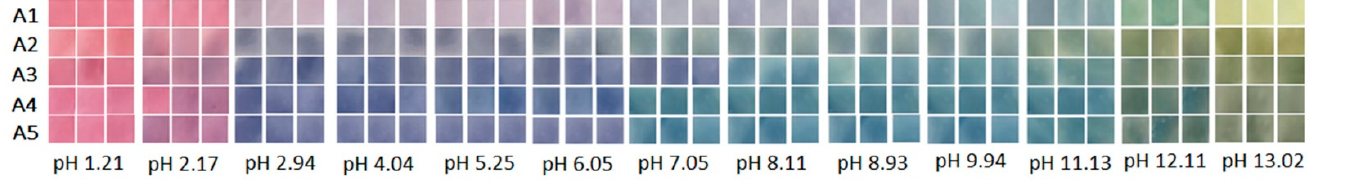
Figure 3. green µPADs array for pH measurement. A1 = 100%RC; A2 = 75%RC-25%BPF; A3 = Figure 3. green µ PADs array for pH measurement. A1 = 100%RC; A2 = 75%RC-25%BPF; 50%RC-50%BPF; A4 = 25%RC-75%BPF; A5 = 100% BPF. Three replicates for each pH value. A3 = 50%RC-50%BPF; A4 = 25%RC-75%BPF; A5 = 100% BPF. Three replicates for each pH